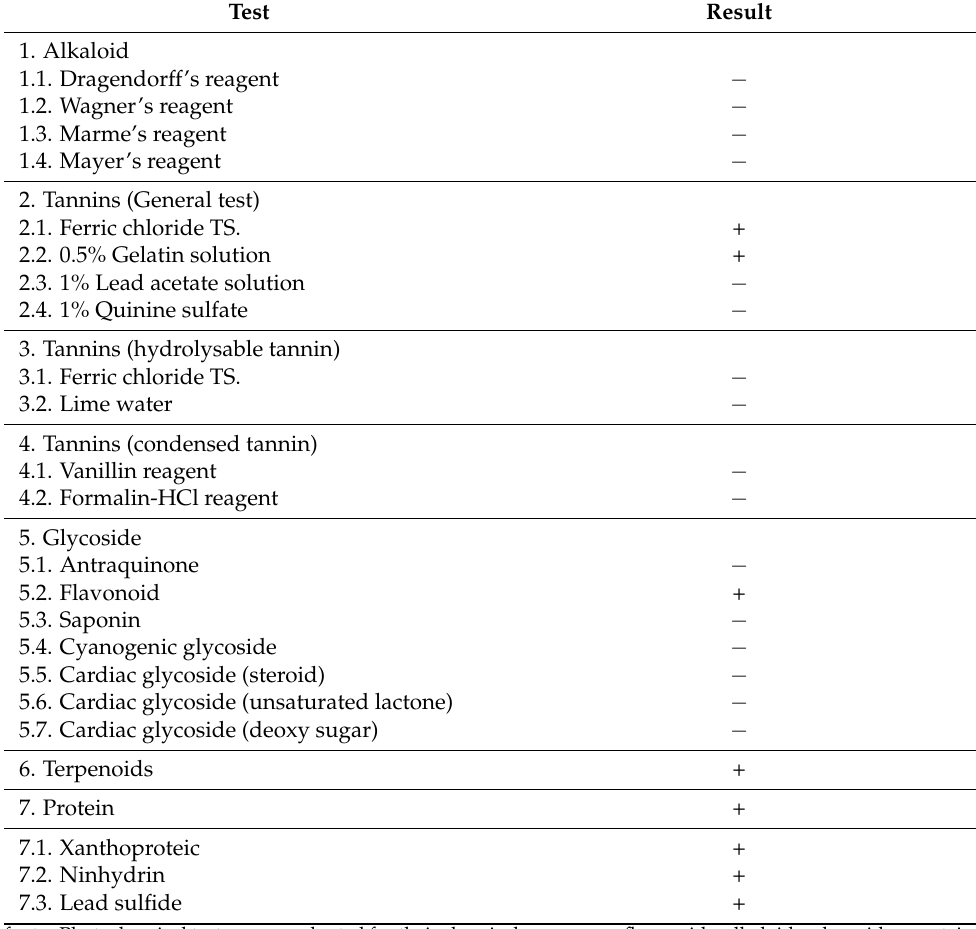
Figure 1. TLC chromatogram of ethanolic extract of G. procumbens : TLC profiles of ethanolic extract of G. procumbens (1), kaempferol (2), quercetin (3) and stigmasterol (4) observed under ( a ) UV at 254 nm, ( b ) UV at 366 nm, ( c ) natural product spraying reagent and ( d ) anisaldehyde-sulfuric acid spraying reagent. Table 1. Phytochemical screening of Gynura procumbens (Lour.) Merr. was determined by chemical reagents.